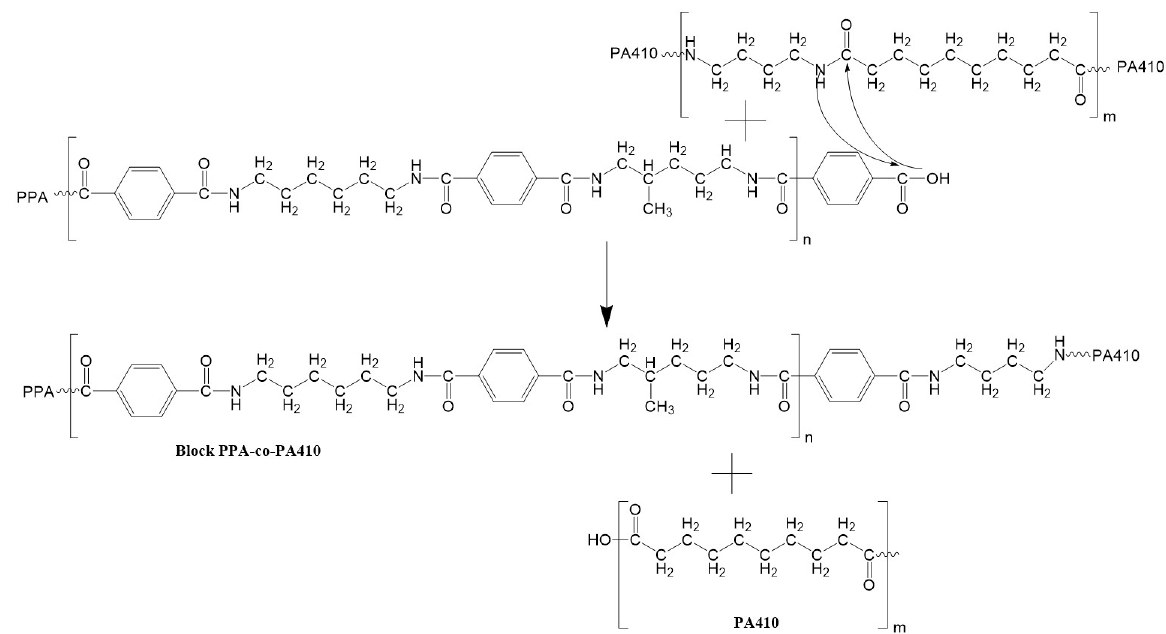
Figure 8. Schematic showing the formation of a block copolymer, between PPA and PA410.